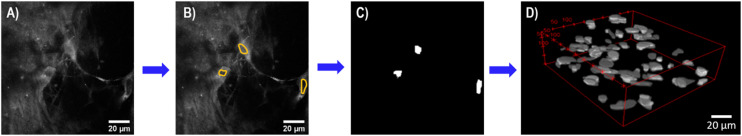
Flowchart summary of semi-automated cell analysis. (A) Representative single optical section of pre-osteoblasts with CNF autofluorescence. (B) Cell nuclei (yellow) were manually identified in every single optical section using ImageJ. (C) Segmented cell nuclei converted into binary mask for each optical section. (D) Representative 3D optical imaging stack of binarized cell nuclei used by ImageJ 3D Objects Counter to identify 3D centroid coordinates for each cell for cell counting. Scale bar is 20 μm. All images acquired using a 40× objective, 3× optical zoom at 815 nm at 5–7 mW.